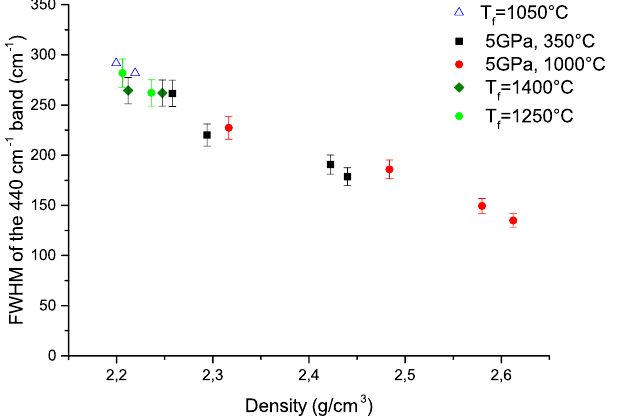
Figure 7. FWHM of the R-band as a function of density for HP-HT and T f